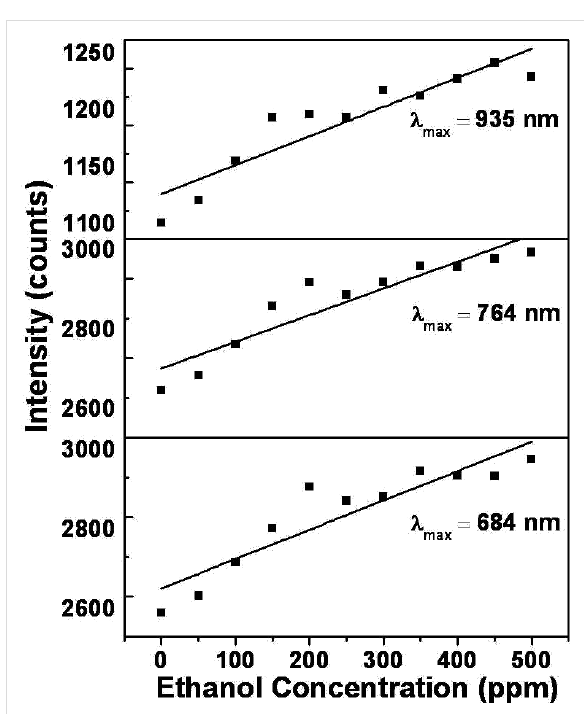
Figure 11: Plot of peak intensity versus ethanol concentration for values λ max = 684, 764 and 935 nm.